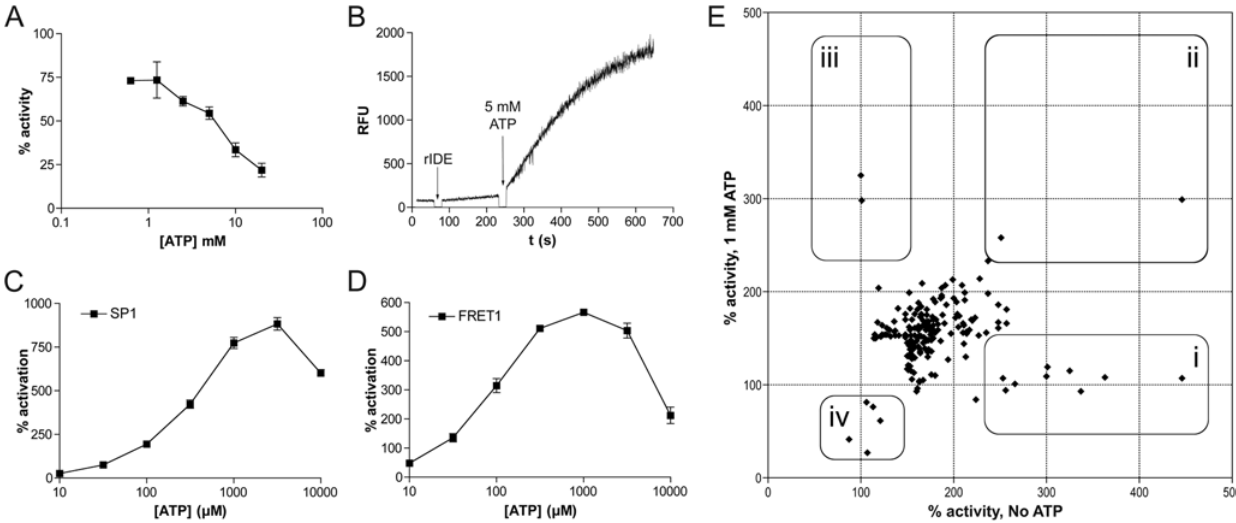
Figure 1. Assay development and rationale for parallel high-throughput IDE activator screening campaigns incorporating ATP. A , ATP inhibits IDE-mediated degradation of A b at physiological concentrations. B , Paradoxical ATP-mediated activation of the IDE-mediated hydrolysis of a fluorogenic peptide substrate. C,D , Dose-response of ATP on the hydrolysis of two structurally similar fluorogenic peptide substrates, SP1 ( C ) and FRET1 ( D ). Note the different degrees of maximal activation obtained for SP1 vs . FRET1. See Fig. S1 for a comparison of the structures of SP1 and FRET1. E , A subset of primary screening data showing percent activity in the presence vs . the absence of ATP (1 mM). Rounded rectangles show different categories of hits that can theoretically be identified using this approach, including ( i ) compounds that mimic ATP, ( ii ) compounds that activate IDE independently of ATP, ( iii ) compounds that act synergistically with ATP, and ( iv ) compounds that disrupt the activation effect induced by ATP. Data are mean 6 SEM for 4 to 5 independent experiments each comprising 3 to 4 replicates and normalized to control wells containing no ATP. For panels A , C and D , all data for concentrations of ATP above 10 m M are significantly different from the no-ATP controls ( P , 0.05). doi:10.1371/journal.pone.0005274.g001 functionality (Fig. 2A,B). When tested at 10 m M, the percent activation produced by different substitutions followed the series: -H , -CH 2 NC < (4-methylphenyl)sulfonyl # -CONH-3-chlorophenyl, with maximal activation produced by Ia2 itself (Fig. S2).